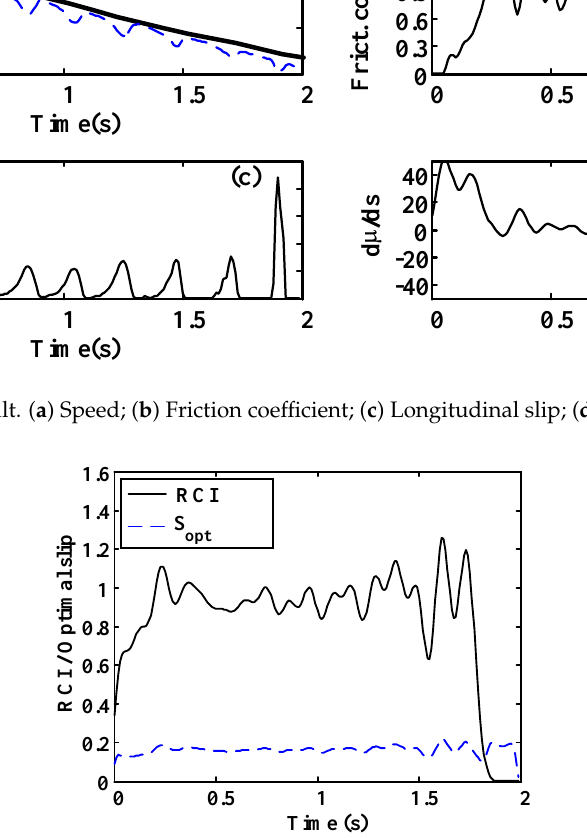
Figure 23. Wet asphalt: Estimated road condition and optimal slip.